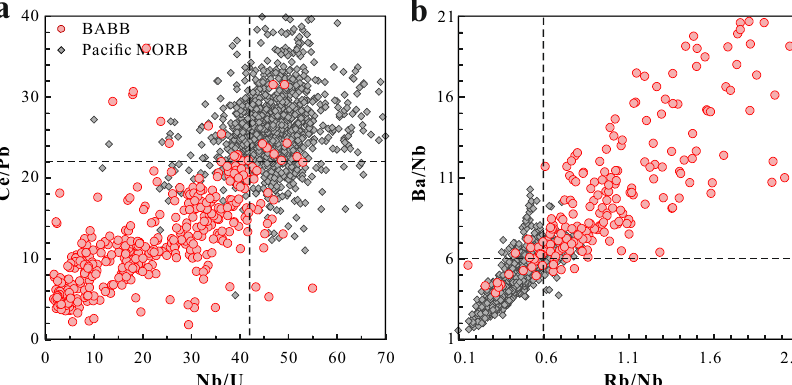
Fig. 4 Trace element systematics of global back-arc basin basalts. Plots of a Ce/Pb vs. Nb/U and b Ba/Nb vs. Rb/Nb for global back-arc basin basalts, as well as Paci fi c mid-ocean ridge basalts. Note the clean separation of the two sets of data. Global back-arc basin basalts, including volcanics from the Lau, Mariana Trough, Scotia and Manus back-arc basins, can be well distinguished with Ba/Nb and Rb/Nb ratios higher than 6 and 0.6, and Ce/Pb and Nb/U ratios lower than 22 and 42 (shown by the dashed lines), respectively. Data sources can be found in the Supplementary Data (Fig. 5a). Global BABB-like MORB have higher H 2 O/Ce ratios of 293 ± 75 compared to those from Paci fi c MORB (205 ± 49),